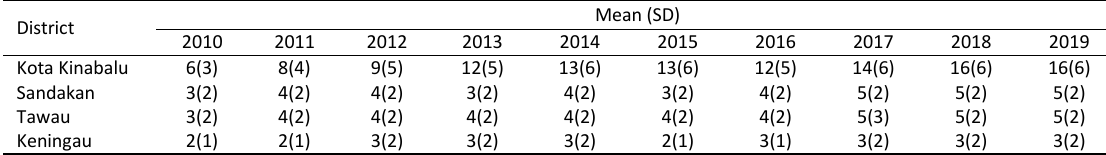
Table 2: Hospital admission for cardiovascular disease in Sabah 2010–2019 District